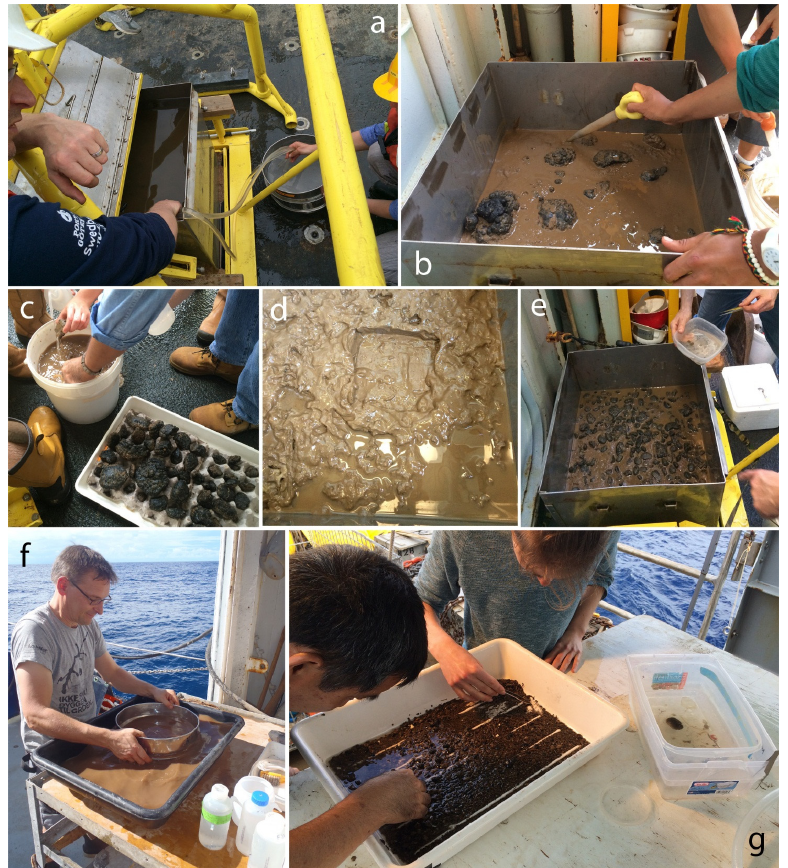
Figure 13. Processing mud samples from box core and EBS on deck. ( a ) Siphoning off the top-water from the box core onto 300 µm sieves; ( b ) Removing remaining surface water with a syringe/baster; ( c ) Picking large megafaunal and macrofaunal animals to a chilled CFSW container; ( d ) Picking nodules and rinsing them to remove mud prior to examination under microscope; ( e ) Cutting the box core (here a sub-sample for live-sorting for DNA taxonomy) prior to sieving; ( f ) Sieving mud from the box core in a submerged sieve under CFSW; ( g ) Picking the remaining heavy fraction of an EBS sample for small bivalves. These process are also illustrated in the Electronic Supplementary Information (Video).